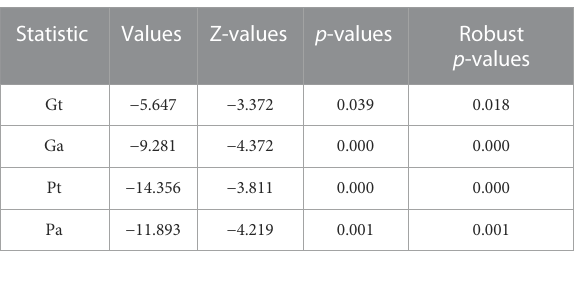
TABLE 5 AMG and CCEMG